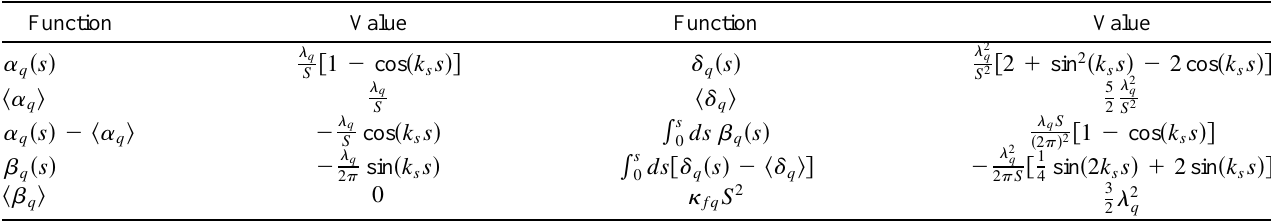
TABLE I. Values of lattice functions defined in Eq. (67) for a periodic quadrupole lattice with k q (cid:2) s (cid:3) (cid:1) ˆ k q sin (cid:2) 2 p s (cid:5) S (cid:3) , with ˆ k q (cid:1) const. Here, l q (cid:8) ˆ k q S 2 (cid:5) 2 p and k s (cid:8) 2 p (cid:5) S